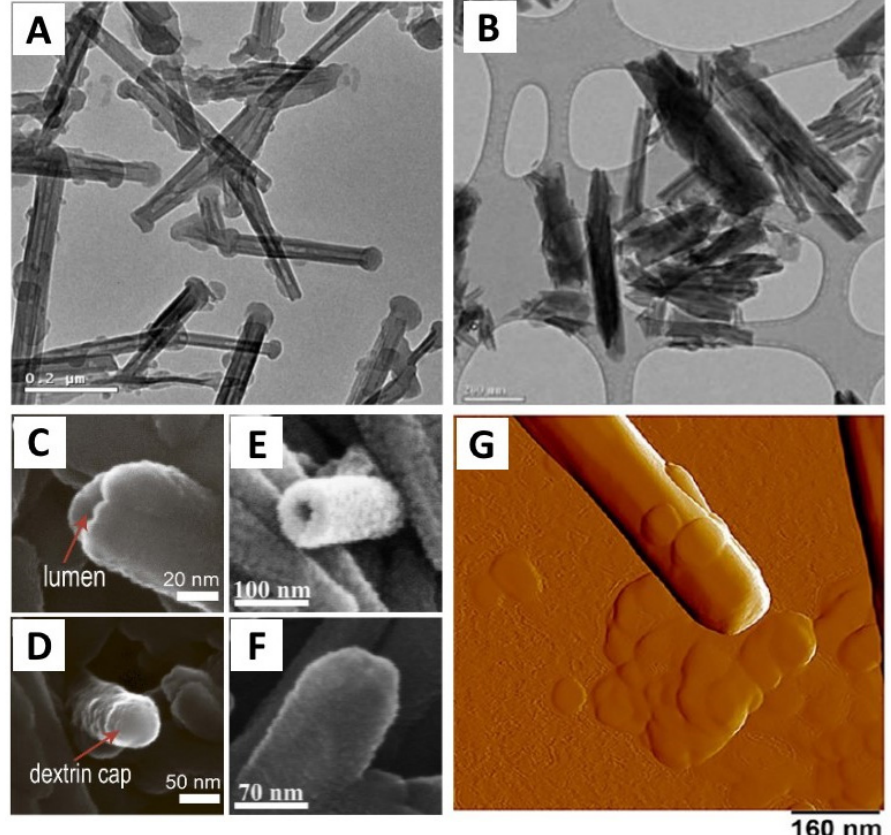
Figure 10. ( A ) TEM image of HNTs with end stoppers of starch complex. Reproduced with permission from Ref. [81]. Copyright 2013 Elsevier; ( B ) TEM image of HNTs loaded with thyme oil and capped with sodium alginate. Reproduced with permission from Ref. [136] Copyright 2017 John Wiley and Sons; ( C ) SEM images of empty HNT and ( D ) HNTs loaded with brilliant green and protected with a dextrin caps. Reproduced from Ref. [137] Copyright 2015 Dzamukova, Naumenko, Lvov, Fakhrullin; ( E ) SEM images of empty HNTs, ( F , G ) SEM and AFM images of HNTs loaded with curcumin and capped by dextrin caps. Reprinted with permission from Ref. [75]. Copyright 2019 American Chemical